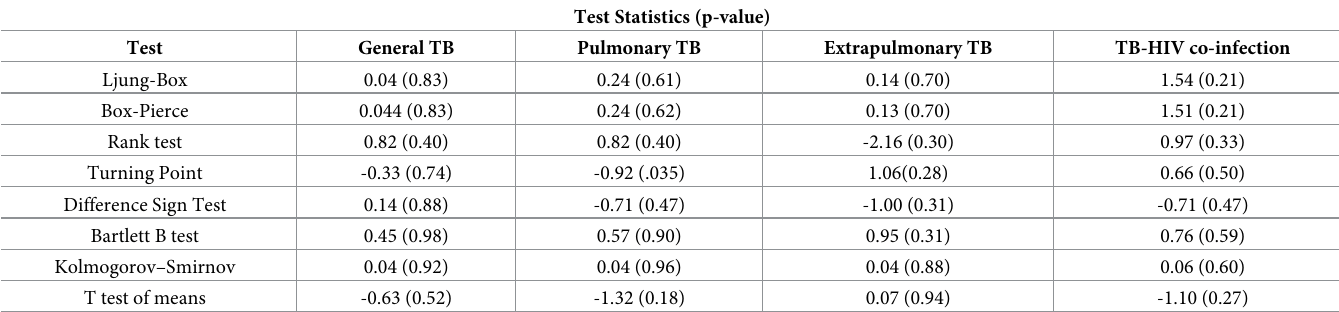
Table 2. Analysis of residues from the temporal modeling of tuberculosis rates, Ribeir ã o Preto, S ã o Paulo, Brazil (2006–2017). Test Statistics